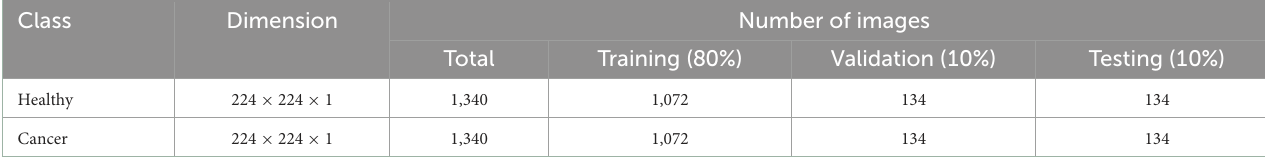
TABLE 2 Dataset considered to verify the proposed framework.